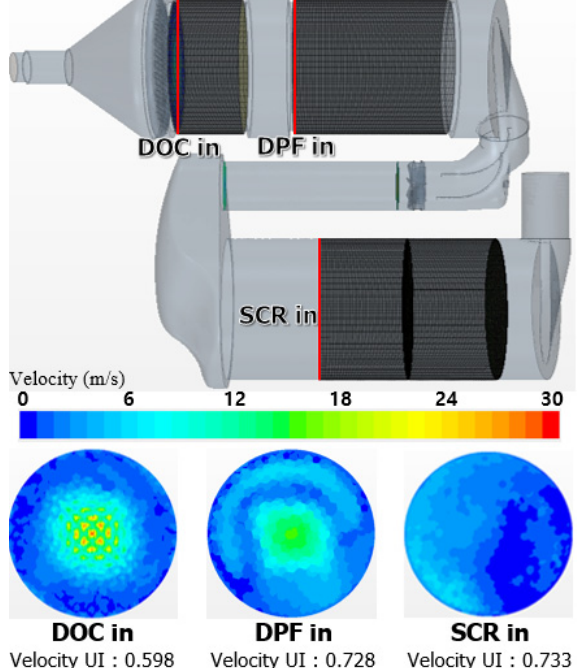
Figure 8. The UI of three locations in the aftertreatment system: inlets of DOC, DPF, and SCR.